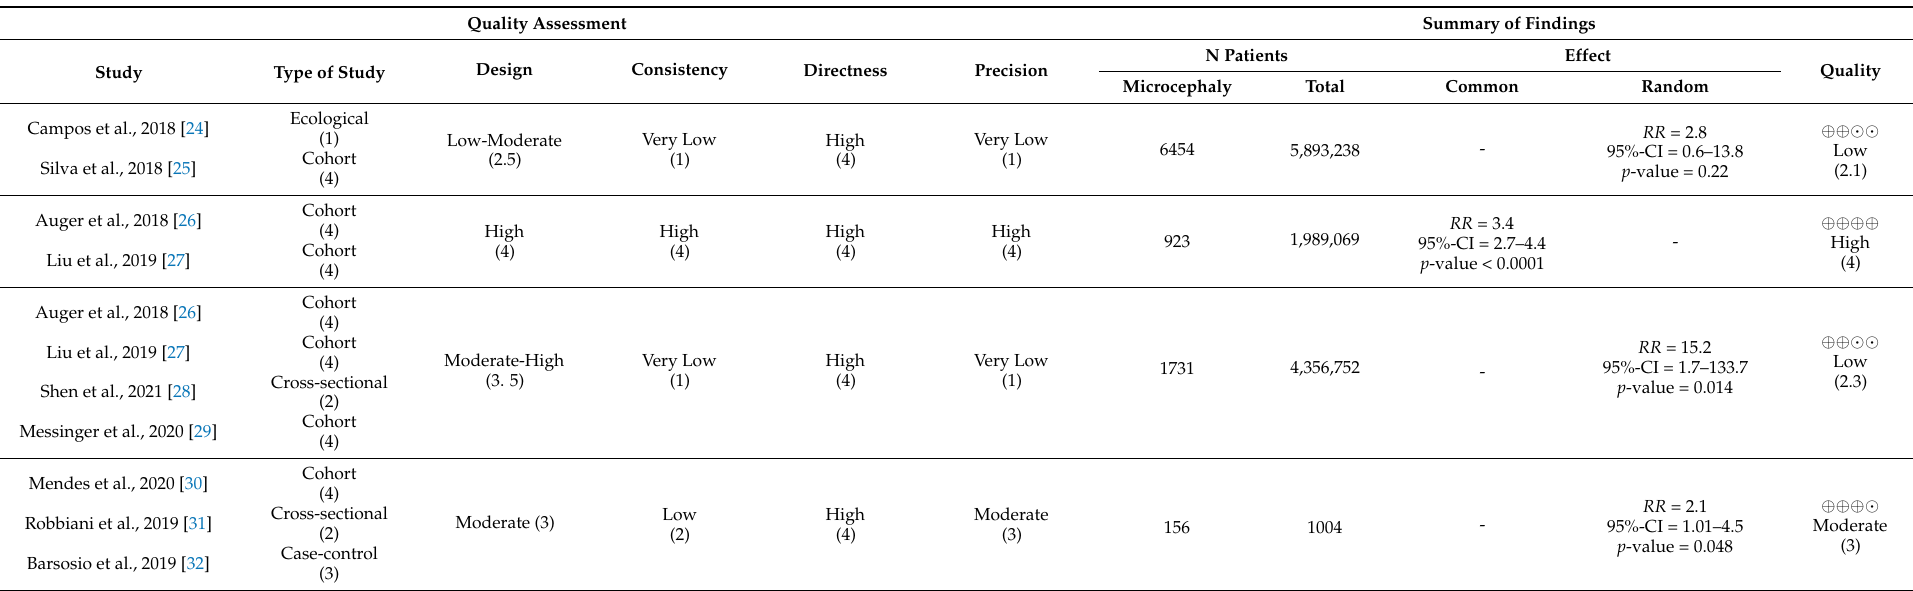
Table 2. Quality analysis of individual-based studies by the GRADE